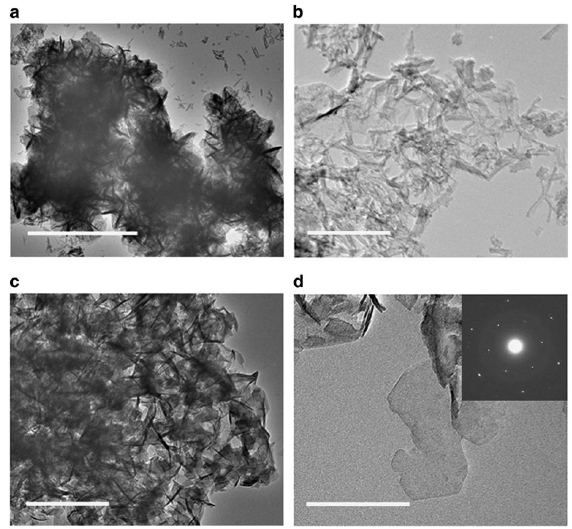
Figure 10. Morphological characterization of TEM images of α -Ni(OH) 2 , compared to Ni 0.75 –V 0.25 LDH: ( a , b ) α -Ni(OH) 2 (scale bar = 1 µ m for ( a ) and 200 nm for ( b )), ( c , d ) Ni 0.75 –V 0.25 LDH (inset of ( d ): SAED pattern (scale bar = 200 nm for ( c ) and 100 nm for ( d )). Reproduced from [32], with permission from Nature Communications, copyright 2016.